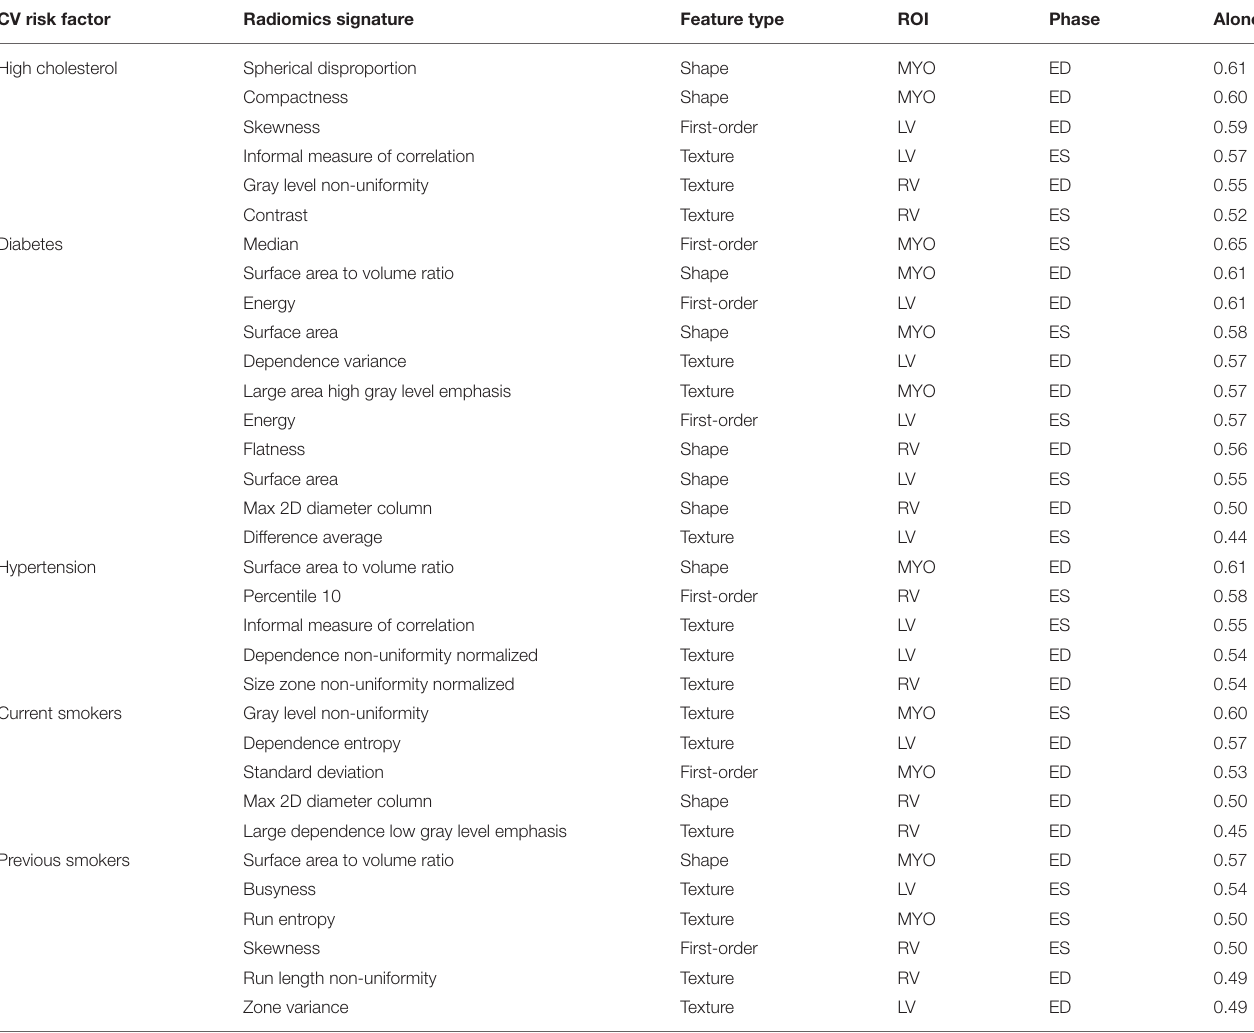
TABLE 2 | Radiomics features selected for each risk factor. Features are presented in order of importance (accuracy using only one feature) in the model for each risk